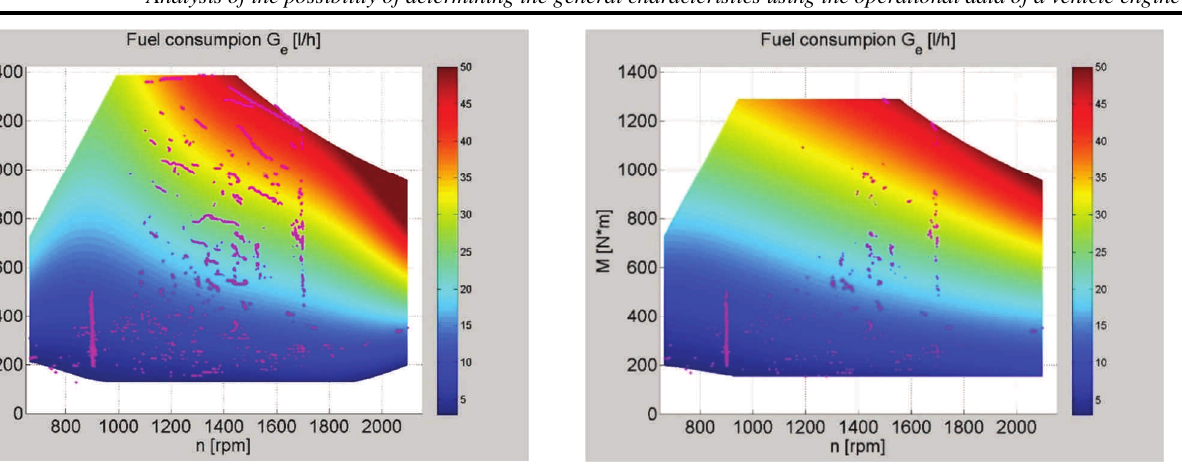
Fig. 7. Characteristics obtained from operational data: static state duration 1 s; derivative limits: 5 N ∙ m/s, 5 rpm/s